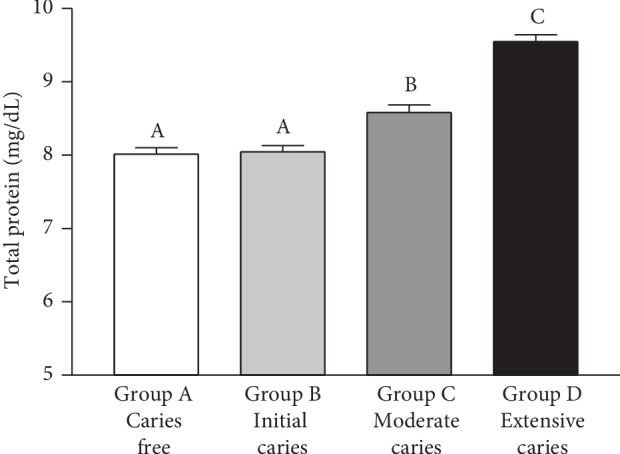
Total protein (mg/dL) in saliva samples of caries-free children (Group A) and in those with caries at different stages (Groups B-D). Bars represent the mean ± SD. Equal letters represent statistical similarity (p > 0.05) and different letters mean statistical differences (p < 0.001).